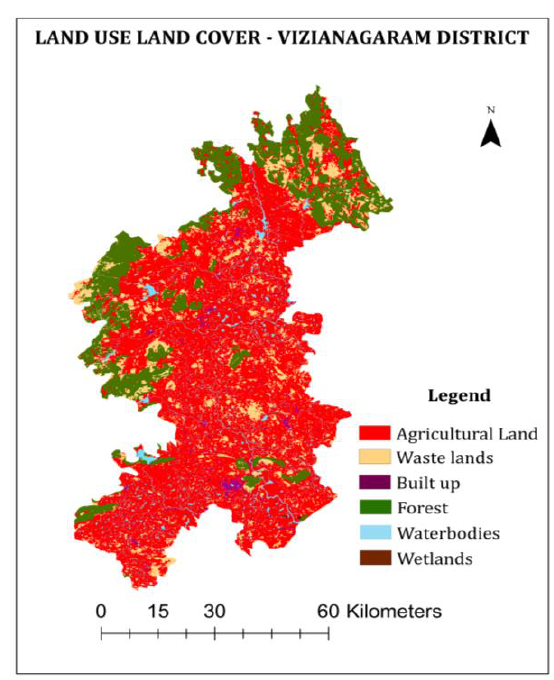
Fig 3: Land use Land cover map